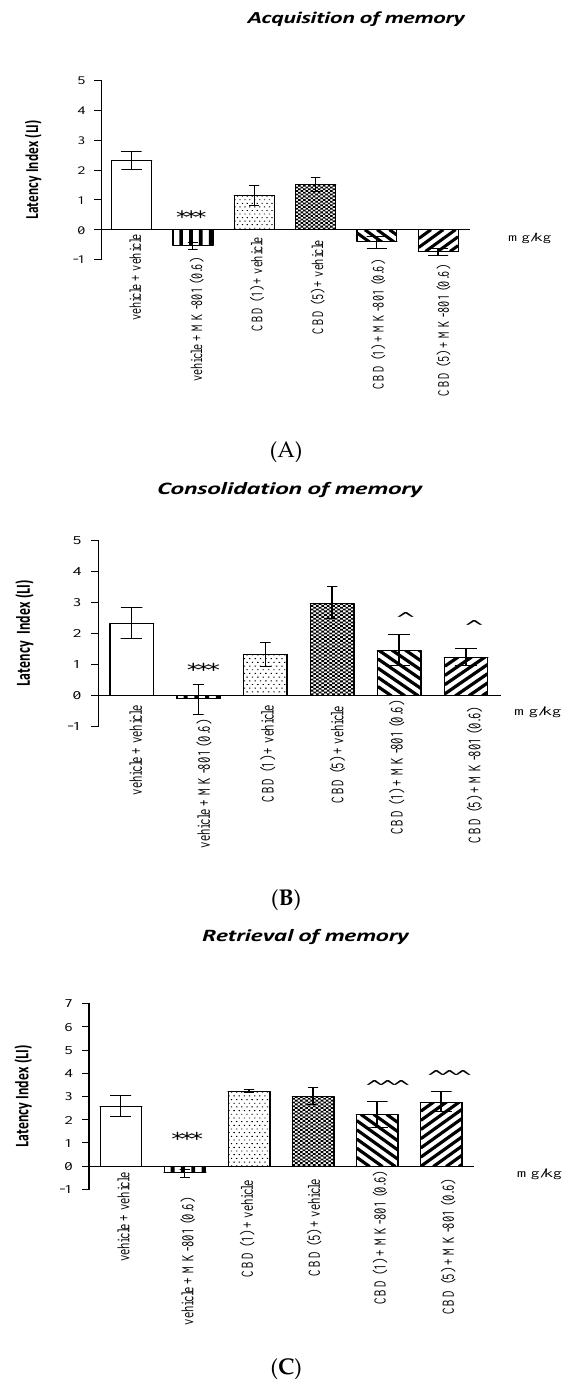
Figure 2. Influence of an acute co-administration of CBD (1 or 5 mg/kg) and an effective (amnestic) dose of MK-801 (0.6 mg/kg) on the cognition-related responses, expressed as latency index (LI), during the acquisition ( A ), consolidation ( B ), and retrieval ( C ) of memory using the PA test in mice. Non-effective doses of CBD (1 or 5 mg/kg) or saline were administered 15 min prior to the amnestic dose of MK-801 (0.6 mg/kg). Last injections were performed 15 min before the first trial (acquisition of memory), immediately after the first trial (consolidation of memory), or 15 min before the second trial (retrieval of memory). The second trial was conducted 24 h after the first; n = 8–9; the means ± SEM; *** p < 0.001 vs. vehicle group; ˆ p < 0.05; ˆˆˆ p < 0.001 vs. saline/MK-801 (0.6 mg/kg)-treated group; Tukey’s